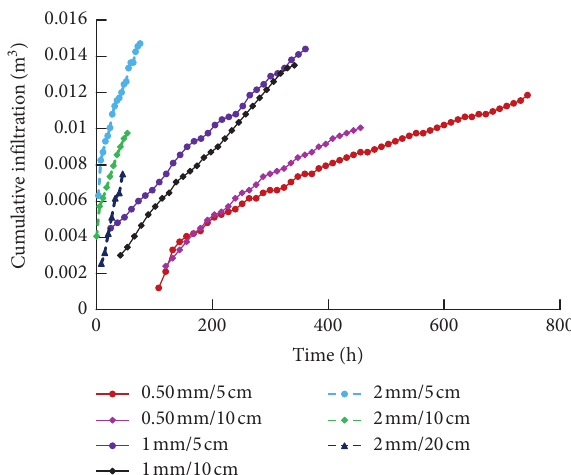
Figure 10: The relationship curve between cumulative infiltration volume and infiltration time after